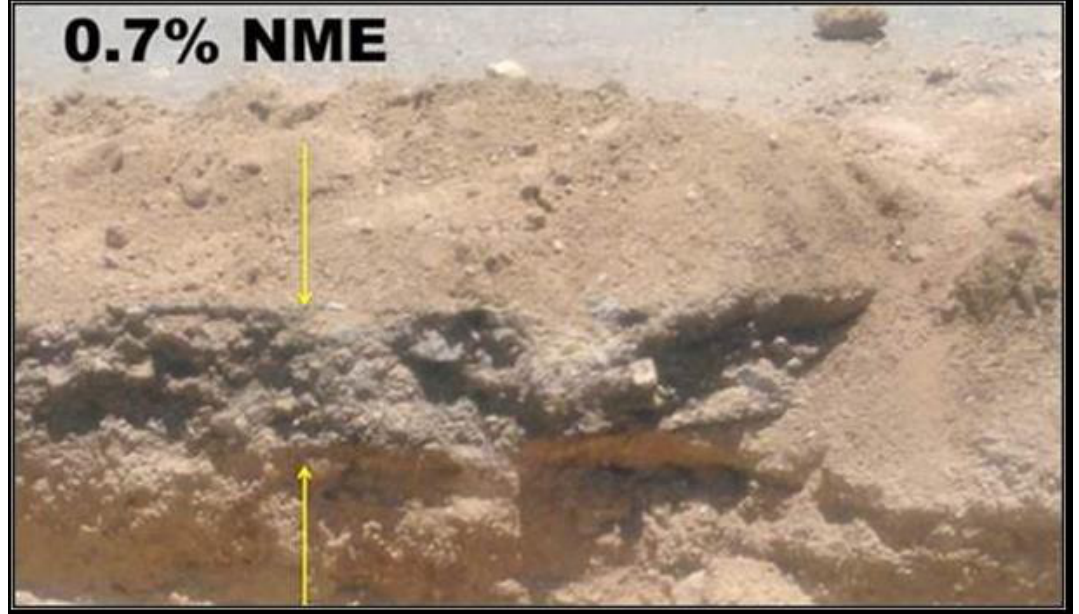
Figure 16. Cut through the stabilised sub-base constructed using a water-cart for distribution of the 0.7% anionic NME stabilising agent added to the construction water and mixed by grader, compacted as shown in Figures 14 and 15.